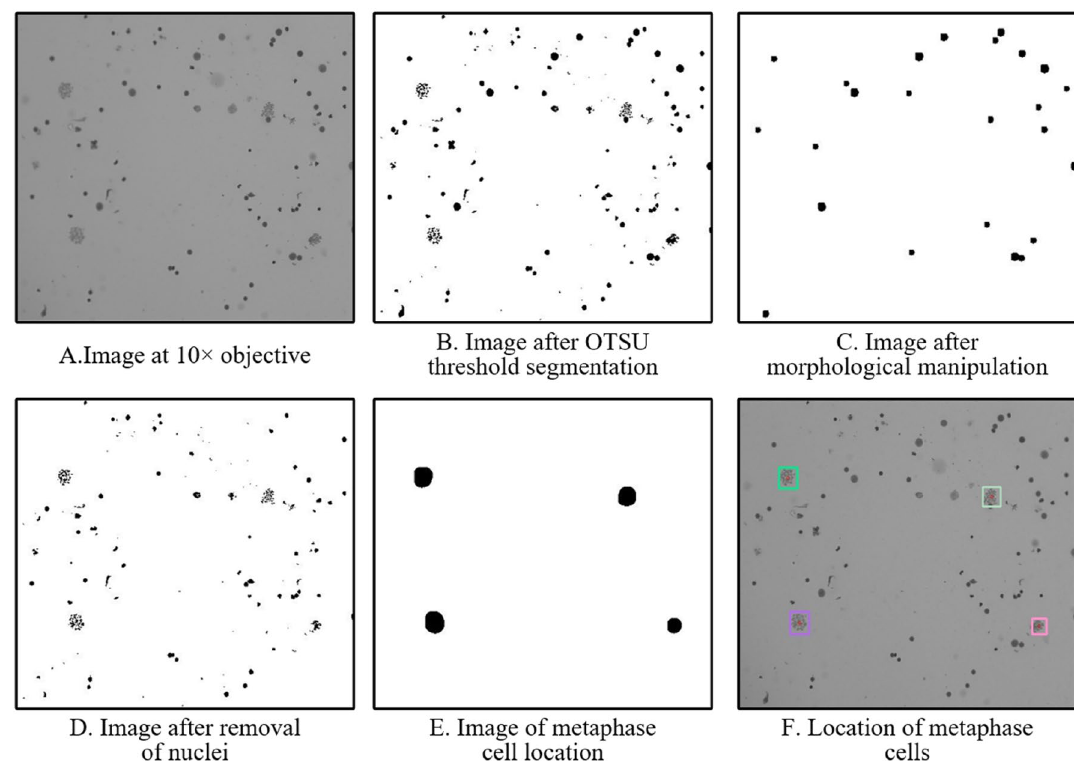
Figure 3. Process of the automatic metaphase cell locating